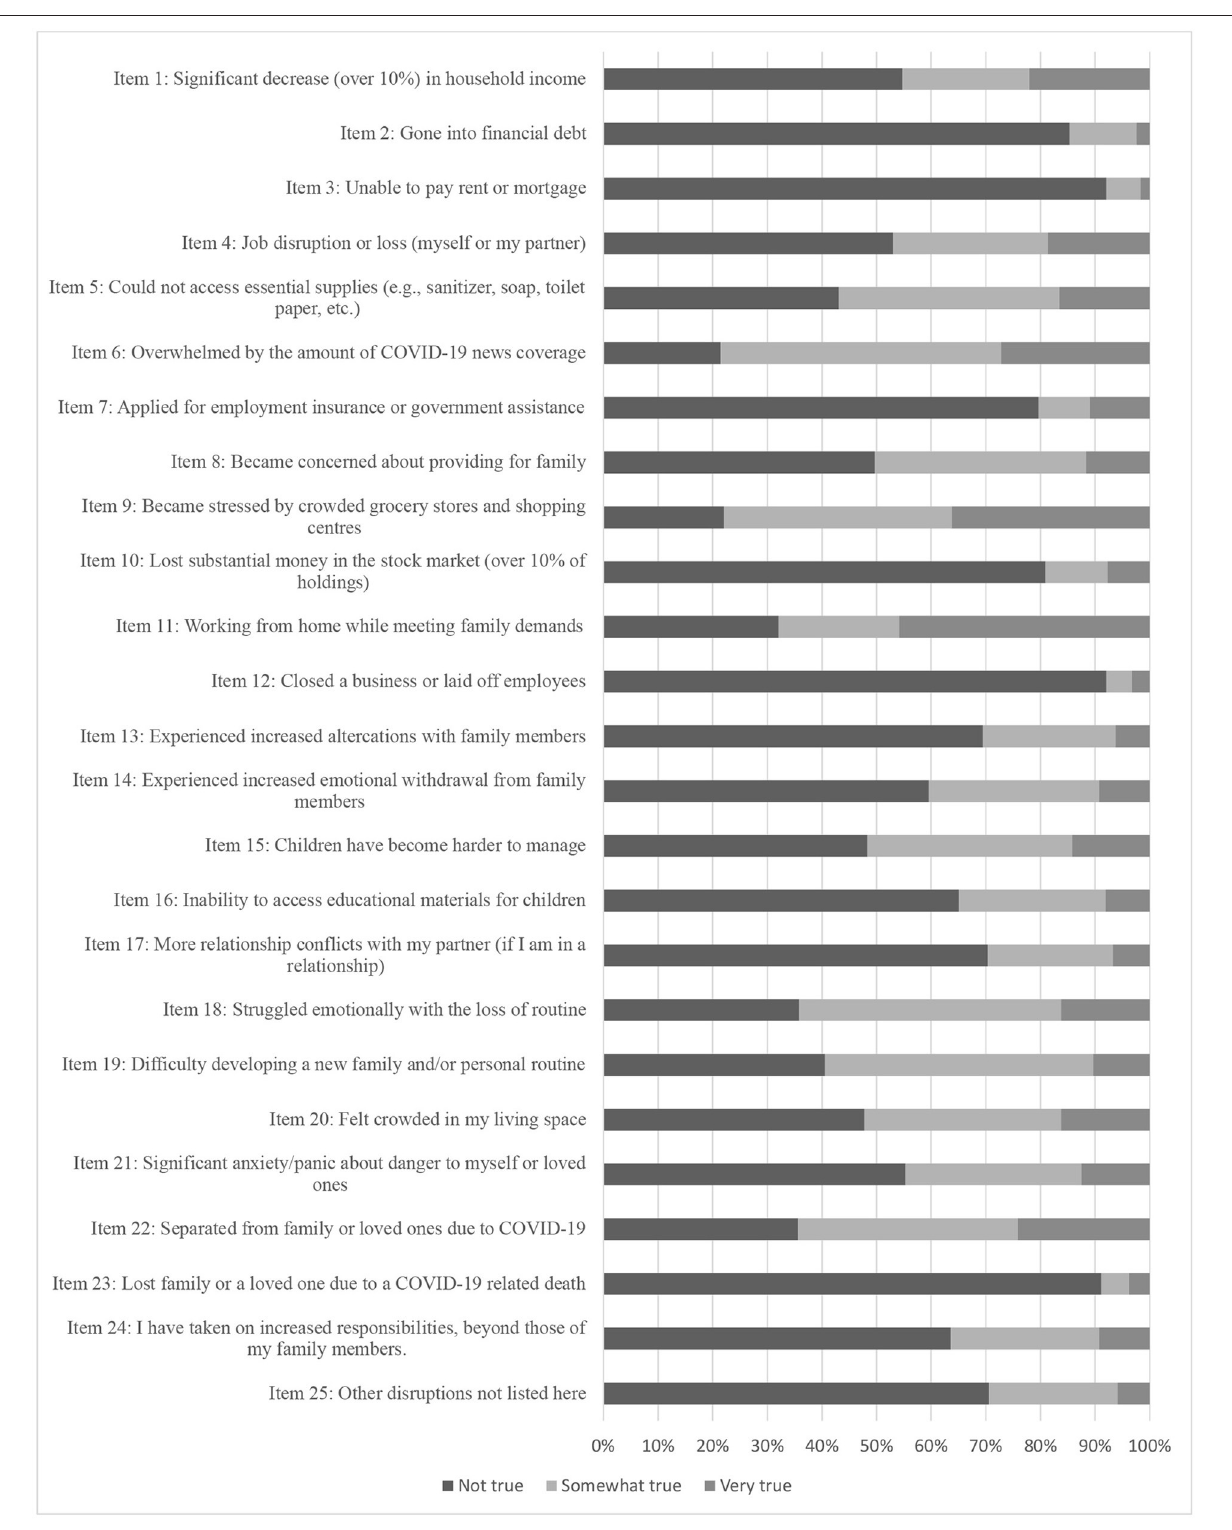
Frontiers in Psychiatry |